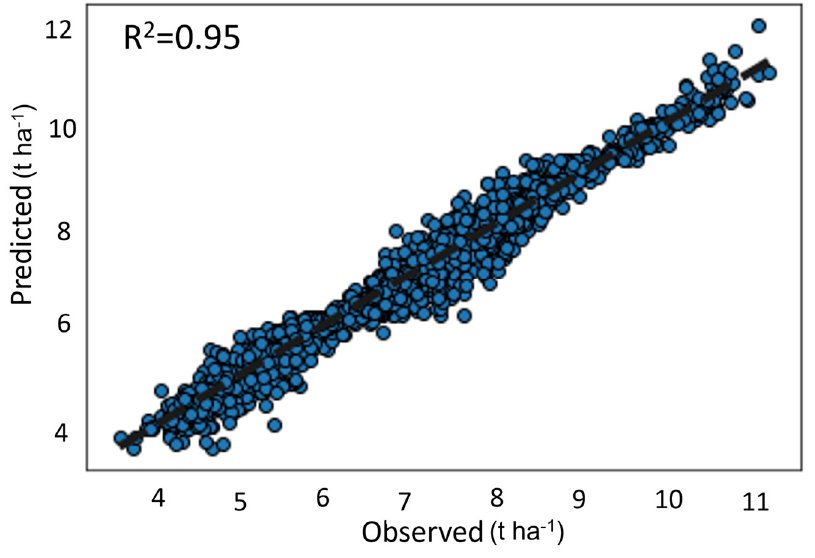
Figure 7. Linear regression between observed and predicted wheat grain yield for the test dataset obtained using the CatBoost algorithm and the S1S2 dataset.